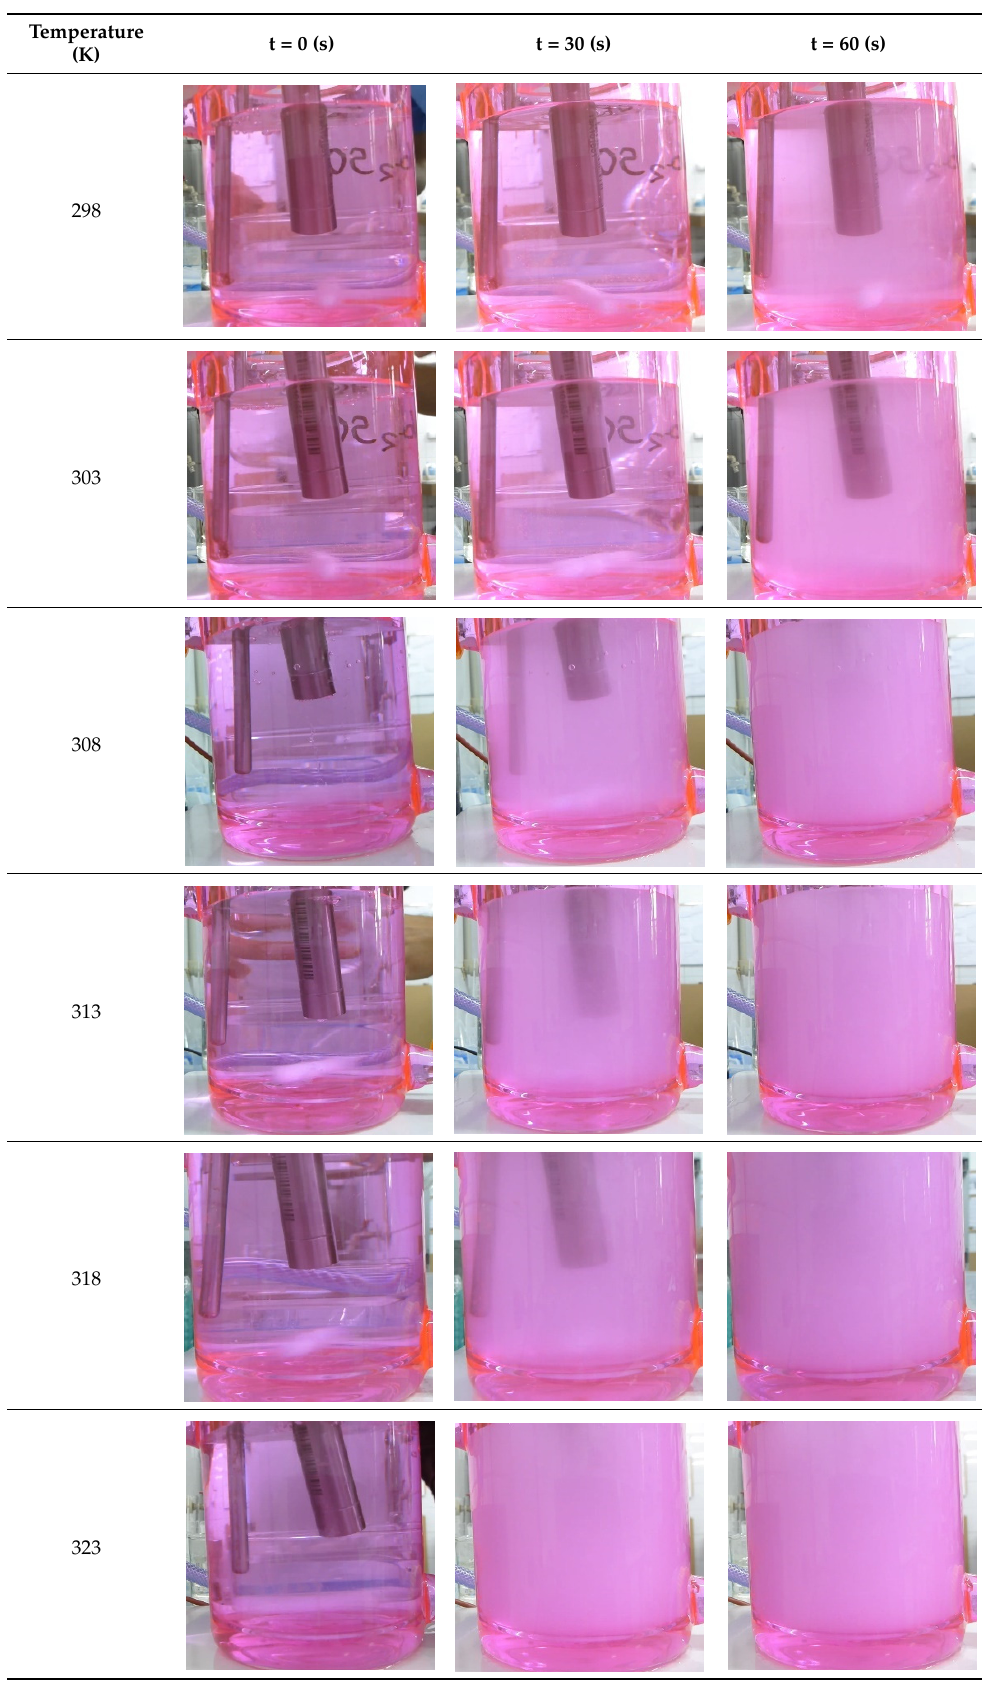
Table 4. Comparison turbidity of solution during precipitation for various temperature.